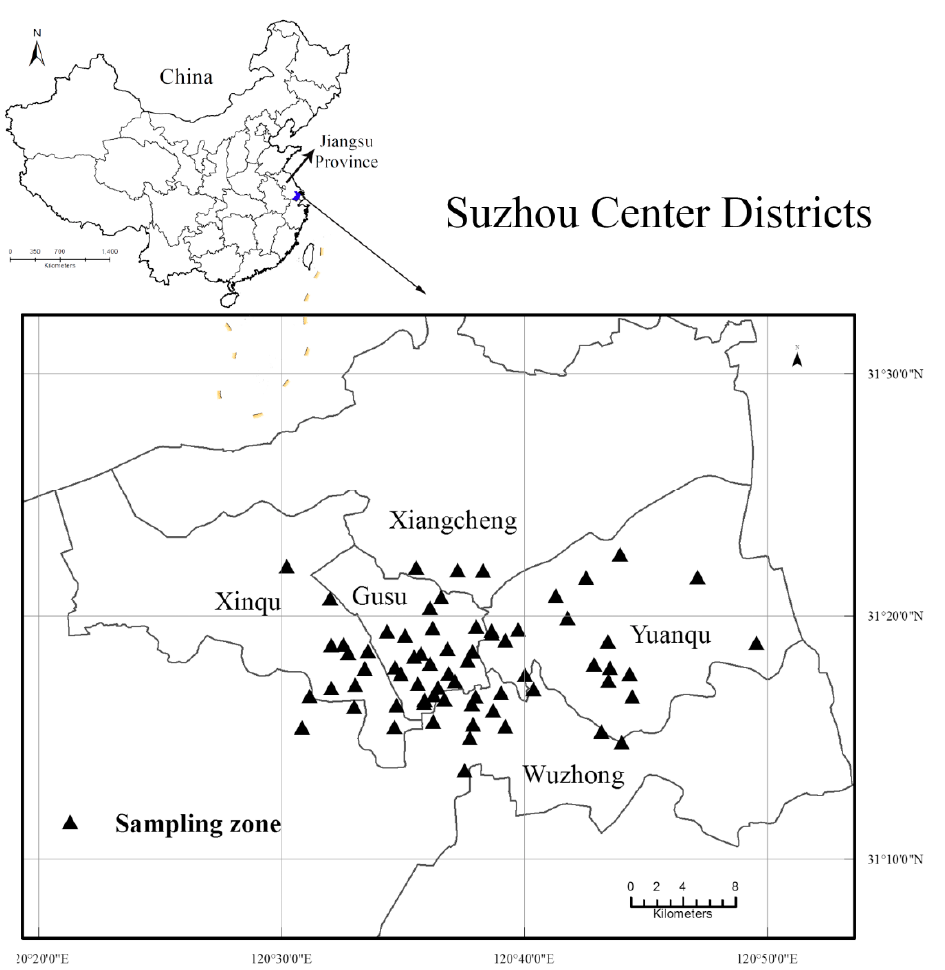
Figure 1. Sampling zones in Suzhou center districts, Jiangsu, China.